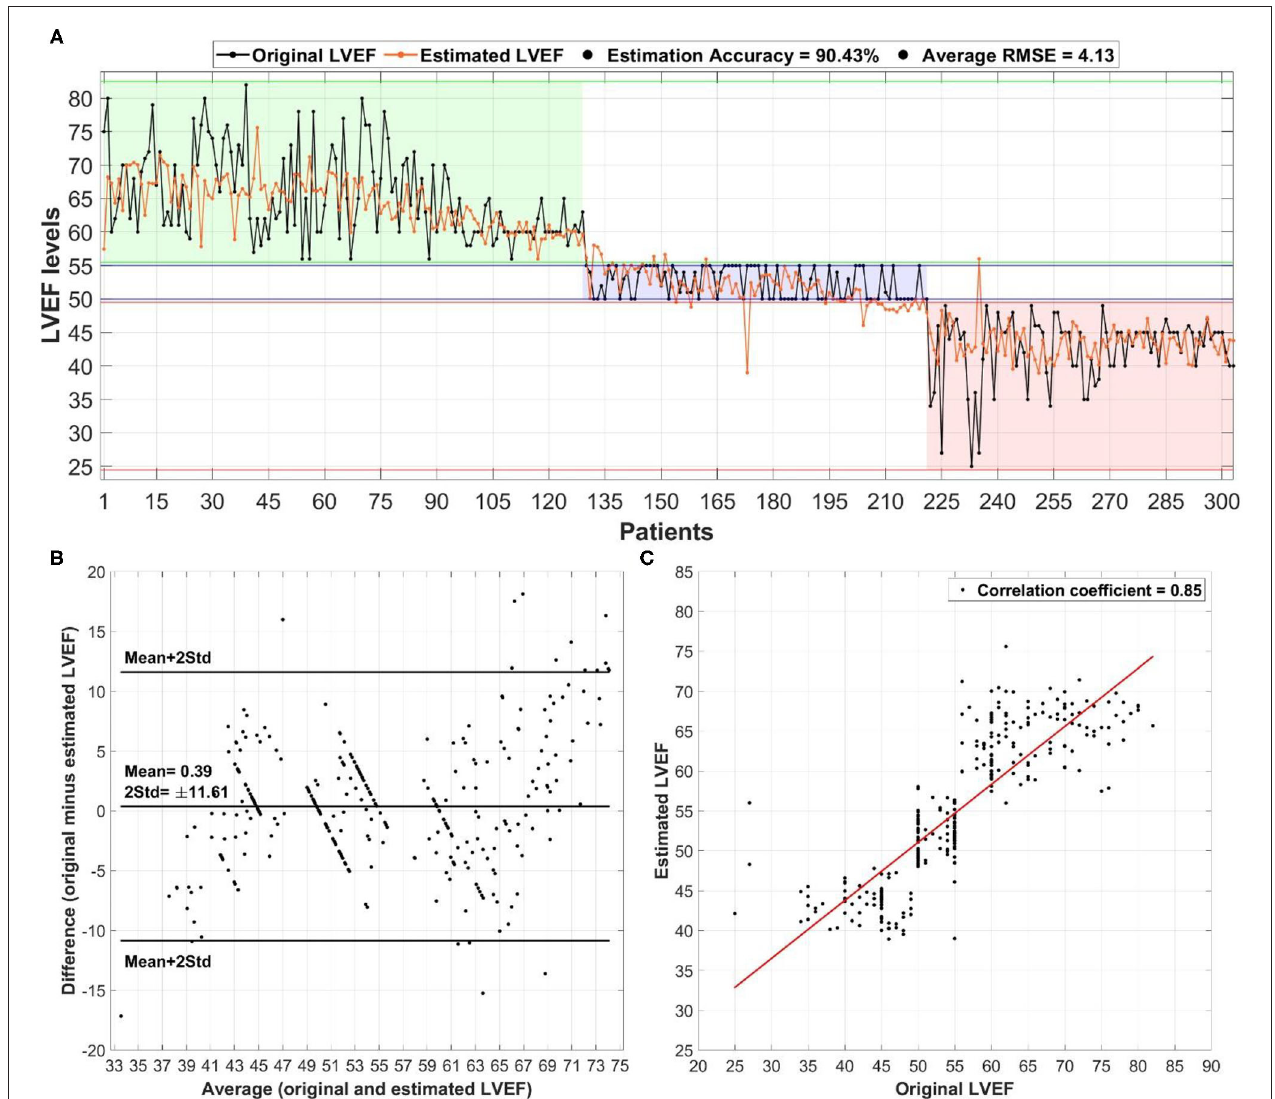
FIGURE 4 | The overall performance of the deep learning-based regression model in estimating left ventricular ejection fraction (LVEF) levels in heart failure patients: (A) estimation of LVEF relative to the original levels alongside the overall accuracy and average root mean square error (RMSE), (B) Bland-Altman plot for the average vs. difference between the estimated and original LVEF levels with the mean ± 2 std difference level, and (C) correlation plot between estimated and original LVEF levels with the corresponding correlation